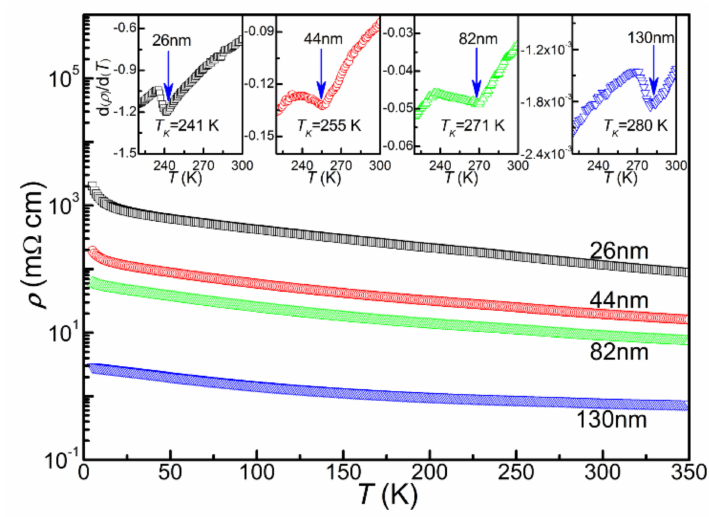
Figure 8. For the temperature dependence of resistivity for the derived CrN thin films, the d ρ / d T results to determine the T K are shown in the insets.